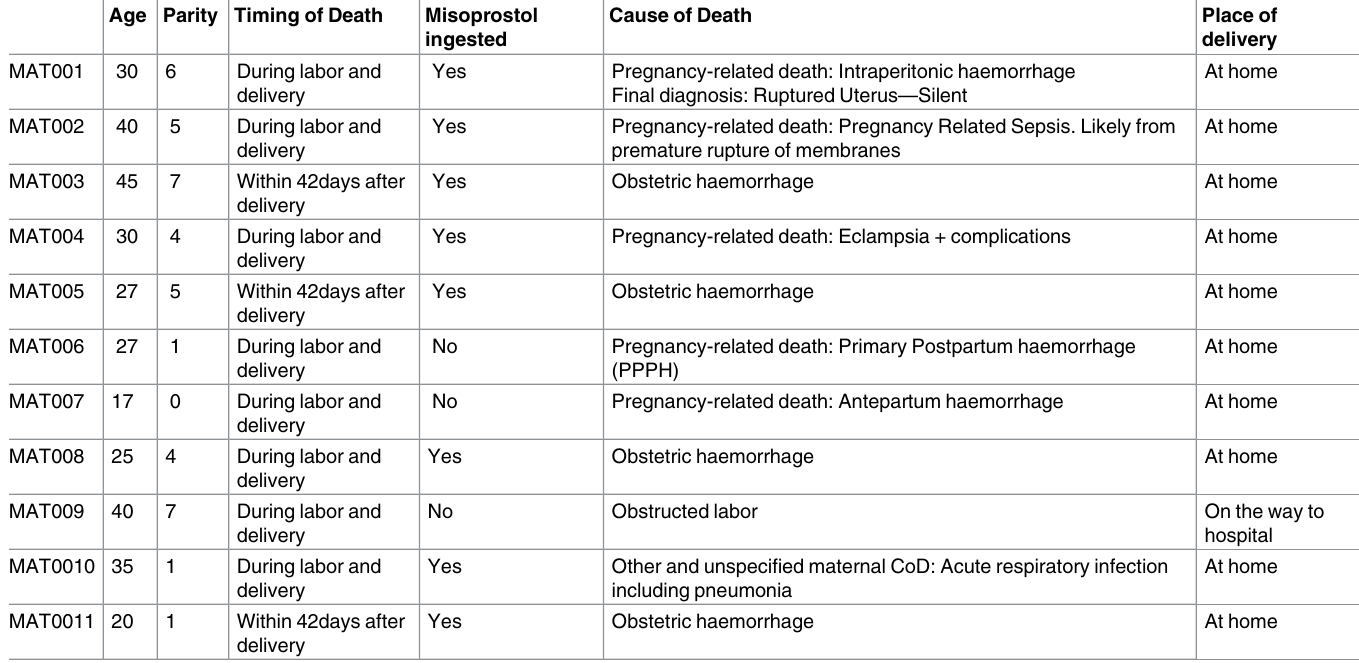
Table 4. Cause of Death as Determined by Verbal Autopsy, including age, parity timing of death and place of